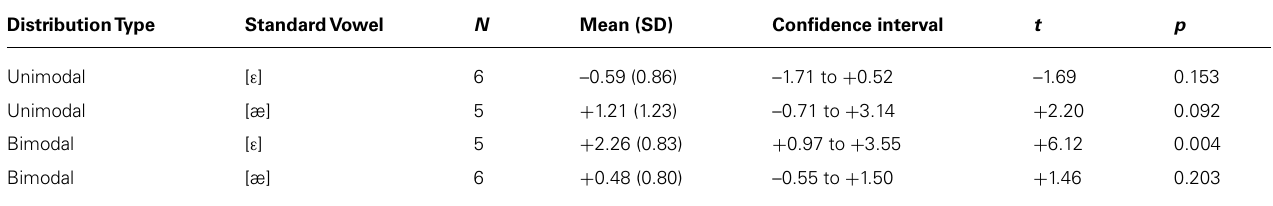
Table 2 | Mean MMR amplitudes (in μ V) between 100 and 500 ms across eight electrodes per subgroup for non-QS data, with within-group standard deviations (SD; between parentheses), and 97.5% confidence intervals.